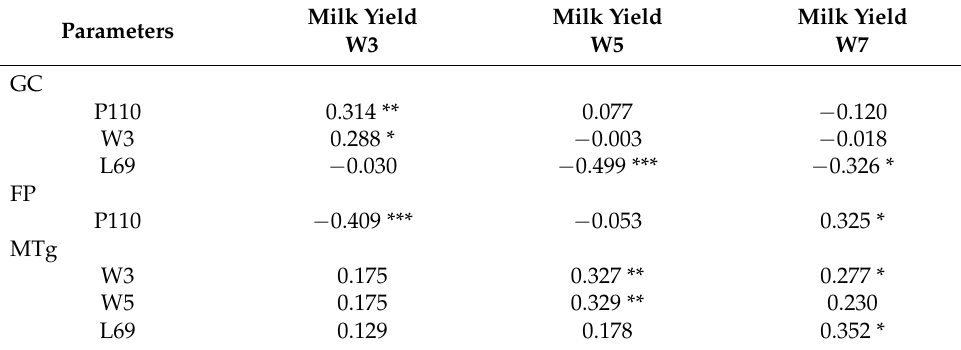
Table 5. Correlation coefficients of residuals of daily milk yield in week 3 (W3), week 5 (W5), week 7 (W7) of lactation, gland cistern (GC) at P110, W3 and L69, fat pad (FP) at P110 and total depth of the mammary gland generous (MTg) at W3, W5 and L69 per udder half.